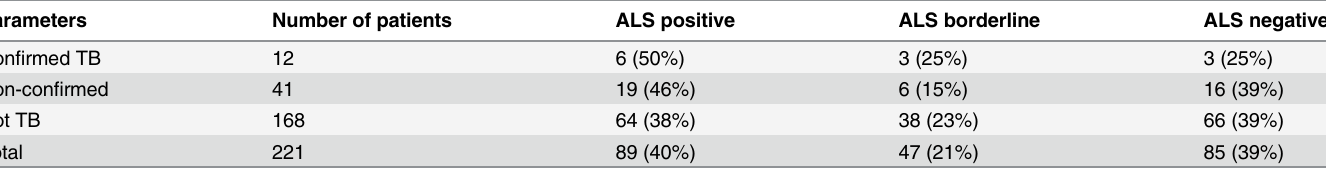
Table 1. Summary results of ALS in blood (using an optical density (cid:1) 0.60 as a positive cut-off and < 0.38 as a negative cut-off), confirmed TB, non-confirmed TB, and not TB in children under five with suspected pneumonia and severe malnutrition.